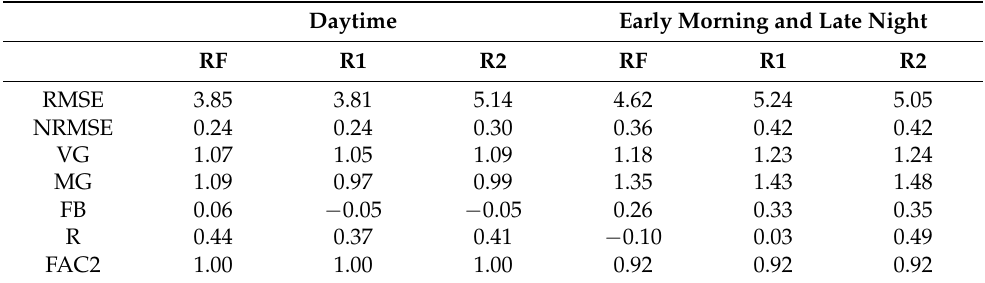
Table 4. Statistical values of the PM 2.5 ( µ g m − 3 ) concentrations simulated at RF, R1, and R2 (green and yellow dots in Figure 1a).